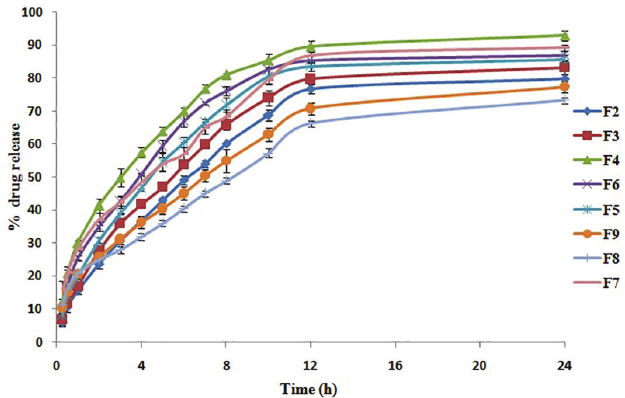
FIGURE 2 - In vitro release profile of developed SLNs.